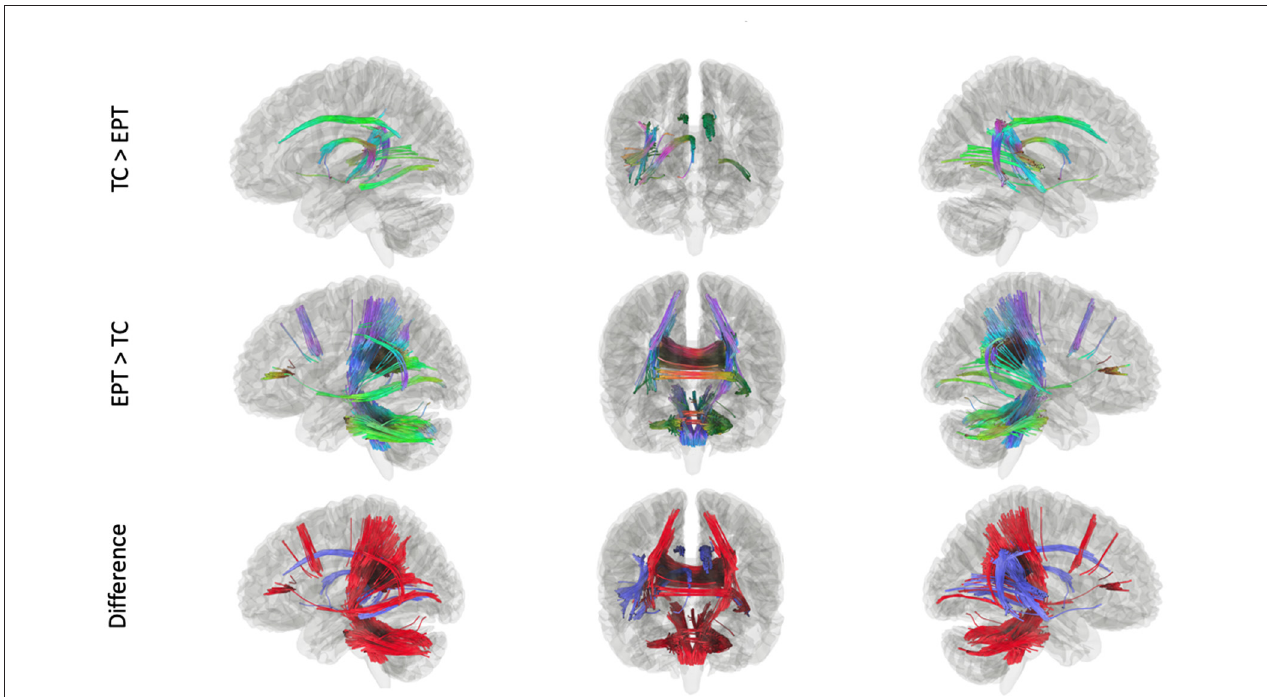
FIGURE 2 | Tracks within the ANOVA (Kruskal-Wallis) white matter pool that were significant in post-hoc analyses. There were no tracks in which EPT-HLD had a significant difference with either EPT or TC (t = 2.0, length threshold = 20 voxels, FDR = 0.05, 4,000 permutations, 2 rounds of tract trimming). There were tracts in which TC > EPT (top row) and EPT > TC (middle row). The bottom row shows the difference in these results (blue = TC > EPT, red = EPT > TC).